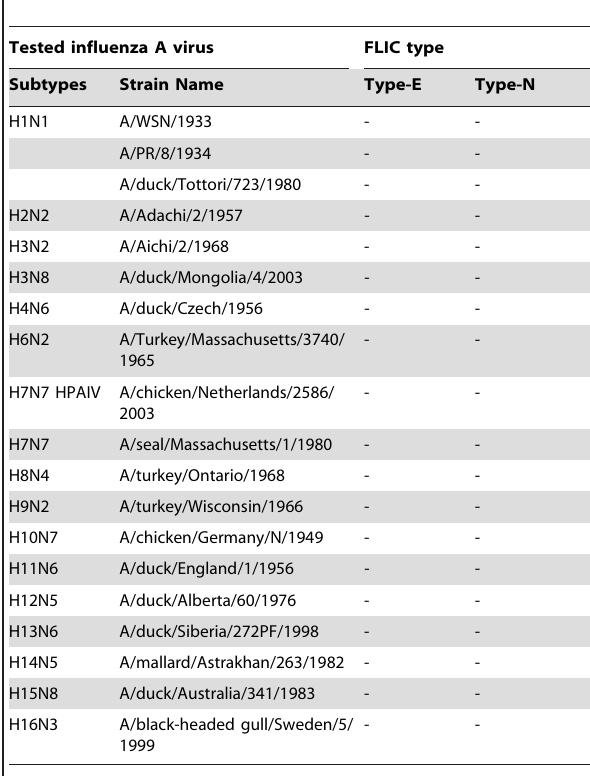
Table 6. Specificities of H5 FLIC for non-H5 subtypes of influenza A viruses.